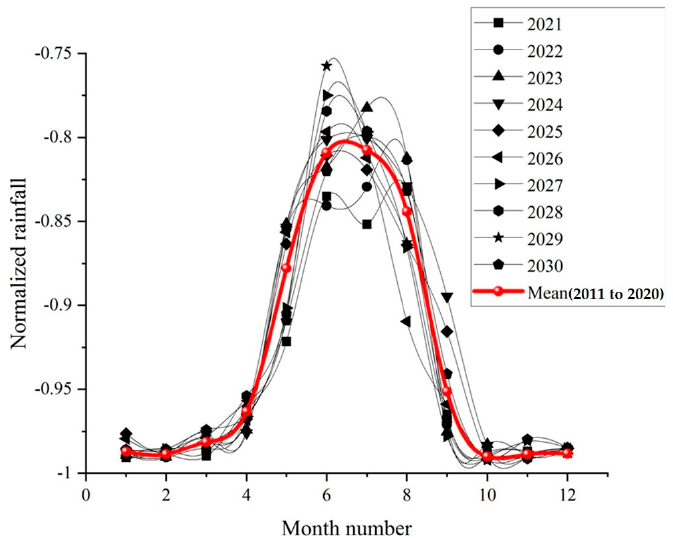
Figure 11. Forecasted normalized monthly rainfall from 2021 to 2030, along with the average rainfall (from 2011 to 2020).